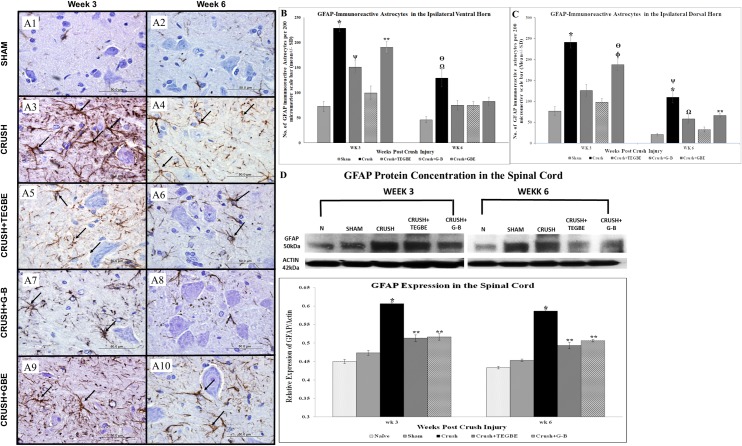
Spinal cord staining with GFAP.A: Representative photomicrographs (100x objective) of the ipsilateral ventral grey horn of L3-L6 spinal cords sections from all groups immunostained for GFAP (GFAP (GA-5): sc-58766, Mouse Monoclonal–Santa Cruz Biotechnology) at week 3 (A1, A3, A5, A7 and A9) and week 6 (A2, A4, A6, A8 and A10) following nerve crush injury. The sham group (n = 12) (A1 and A2) show normal and clear GFAP-immunoreactive astrocytes in the ventral horn. Whereas, the crush group (n = 12) (A3 and A4) display a remarkable increase in GFAP immunoreactive astrocytes. The TEGBE (n = 12) (A5, A6), G-B (n = 12) (A7, A8) and GBE-treated (n = 6) (A9, A10) groups show an observable decrease in the GFAP-immunoreactive astrocytes compared to crush at the week 3 and week 6 post-injury. Black arrows indicate the GFAP immunoreactive astrocytes. Scale bar = 200 μm. B, C: Bar graphs showing the average number of total GFAP immunoreactive neurons in the ventral grey horn (B) dorsal grey horn (C) and obtained from the different experimental groups at week 3 and week 6 following sciatic nerve injury. Data show a significant decrease in the number of the GFAP-immunoreactive astrocytes in the ventral and dorsal grey matters at week 3 and week 6 post-injury. B: Note the significant increase in the GFAP immunoreactive astrocytes in the ventral horn in crush compared to sham and treated groups at week 3 and week 6 post-injury. * indicates p<0.0001, crush group vs. sham group, TEGBE and G-B treated groups. ** indicates p<0.0001, GBE treated group vs. sham group and G-B-treated group. Ψ indicates p<0.002, TEGBE-treated group vs. sham group and G-B-treated group. Ω indicates p<0.0001, crush vs. sham group. ϴ indicates p<0.005, crush vs. all treated groups. C: Note the significant increase in GFAP immunoreactive astrocytes in the dorsal horn in crush compared to sham, TEGBE and G-B and GBE-treated groups at week 3 and week 6 post-surgery. * indicates p<0.0001, crush vs. sham group, TEGBE and G-B-treated groups. ψ indicates p<0.02, crush compared to GBE treated group. ɸ indicates p<0.0001, GBE treated group vs. sham group and G-B-treated group. ϴ indicates p<0.02, GBE-treated group vs. TEGBE-treated group. ** indicates p<0.009, GBE-treated group vs. sham group. Ω indicates p<0.05, TEGBE-treated group vs. sham group. Data represent mean ± SD (n = 6 /group). D: Illustrates the Western blot graph and the statistical data analysis of the GFAP expression in the spinal cords obtained from all the experimental groups except GBE treated group due to a shortage of animal supply. In each group, the lumbar spinal cords from three rats were analyzed at week 3 and week 6 post-injury. The antibody used to detect the GFAP (Anti-GFAP antibody (ab7260)–Abcam Biochemical®, Cambridge, MA, USA). The bar graph shows the GFAP density in spinal cord samples (n = 3 rats/group) normalized with densities of actin band (Molecular weight-42). The labeled GFAP bands were quantified. Note that the crush group exhibits a significant (*p<0.0001) increase in the GFAP expression compared to sham and naive (n = 6) groups. Whereas the TEGBE and G-B treated groups show a substantial decrease in GFAP immunoblotting, but still significantly (**p<0.001) higher compared to naive and sham animals at weeks 3 and 6 post-injury.